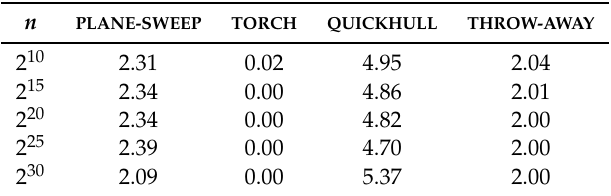
Table 8. The number of orientation tests executed by the competitors [divided by n ] for the square data